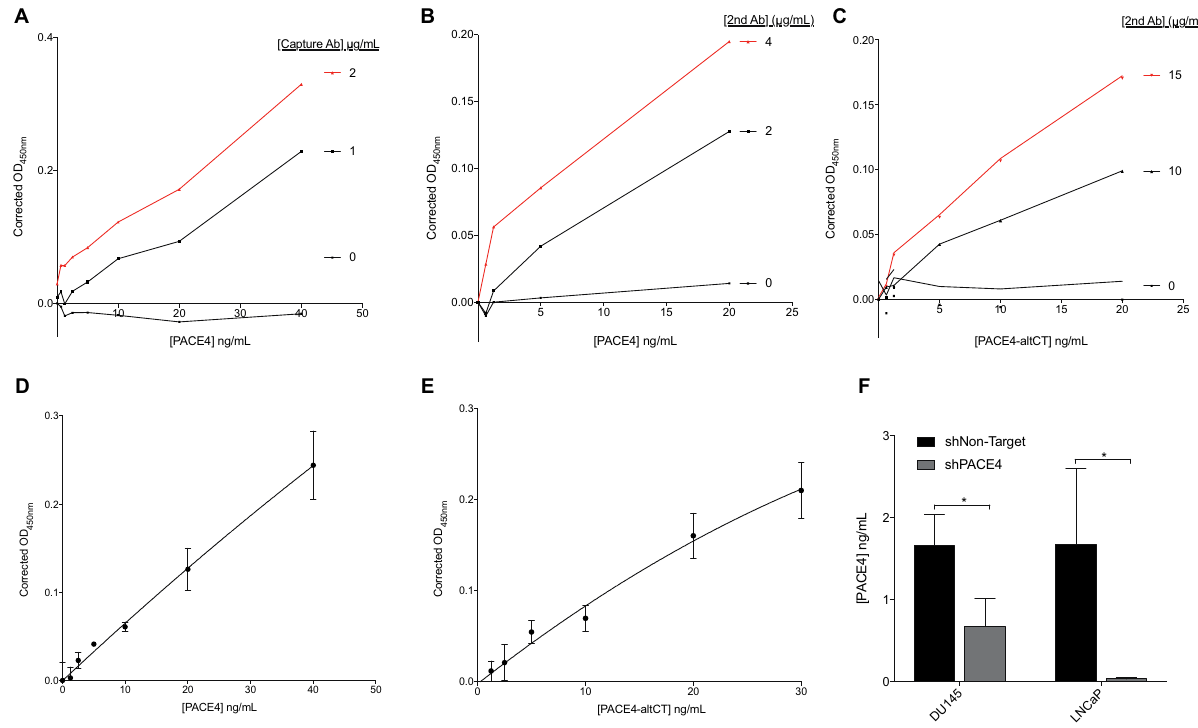
Figure 4. Development, optimization and validation of PACE4 sandwich ELISA assays. Antibody validation assays for ( A ) PACE4 capture antibody, ( B ) total-PACE4 sandwich (2nd) antibody and ( C ) PACE4-altCT sandwich (2nd) antibody. ( D ) Representative standard curves of total PACE4 and ( E ) PACE4-altCT. Assays from A-E use recombinant PACE4 (diluted in human serum diluted 1;5 with PBS). ( F ) Quantitation of PACE4 concentration in the conditioned culture media of control (shNon-Target) and PACE4-knockdown (shPACE4) DU145 and LNCaP PCa cells (n = 3). * indicates P value < 0.05. Data are means ±